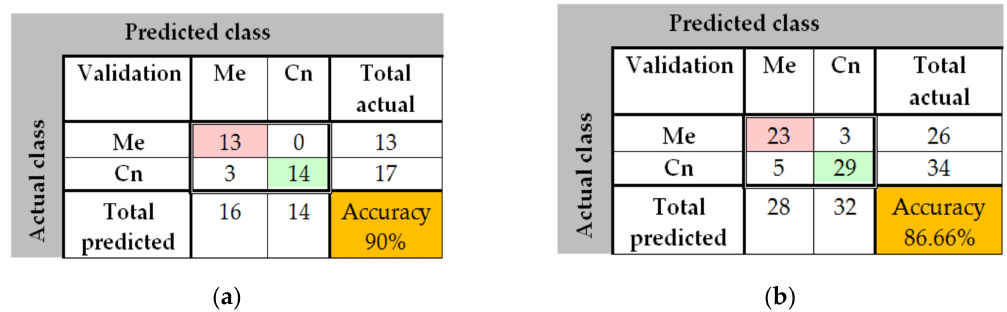
Figure 25. ( a ) Confusion matrix for validation phase in the case of NasNet-Large CNN for the PH 2 database; (b) Confusion matrix for validation phase in the case of NasNet-Large CNN for the ISIC 2019 database.